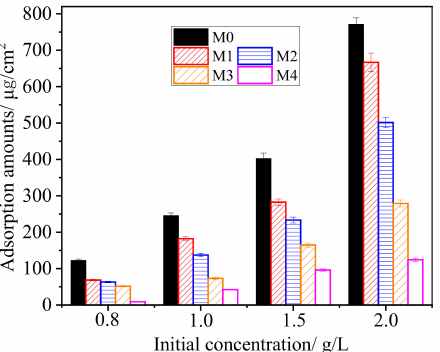
Figure 5. Adsorption amounts of BSA on various prepared PVDF membranes under different BSA concentrations in the